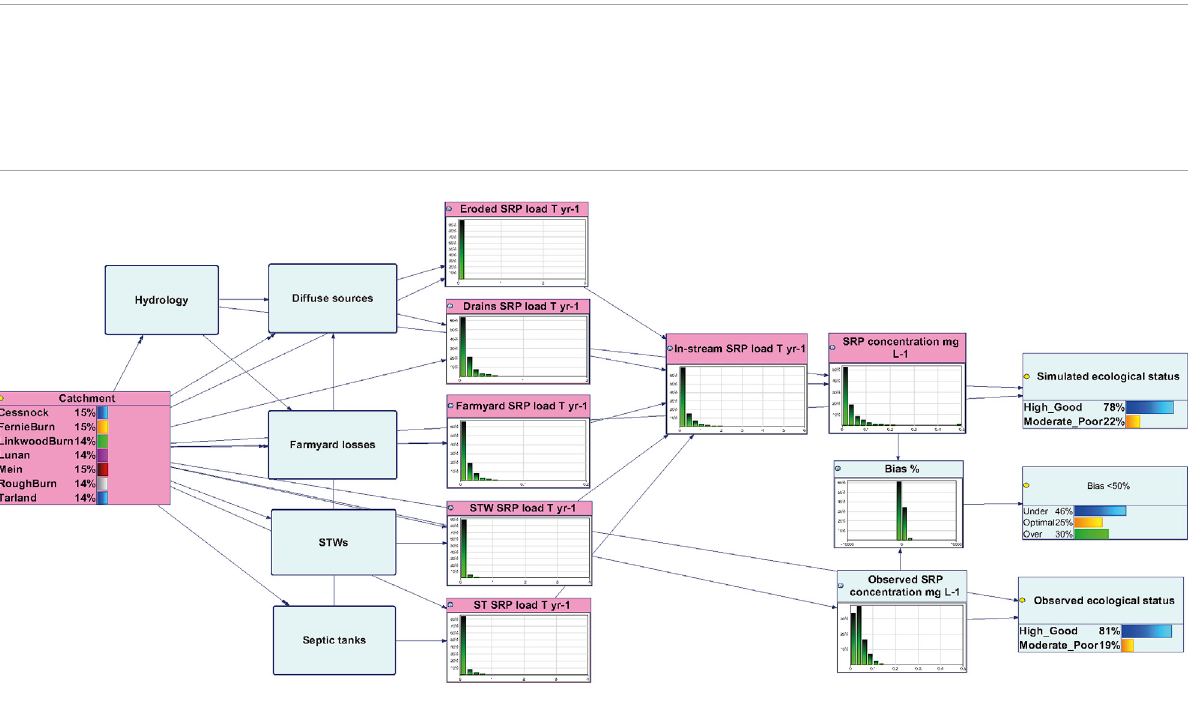
FIGURE 3 The overall structure of the hybrid model, with fi ve sub-modules. (The structure of sub-models is presented in Supplementary Figure S1).